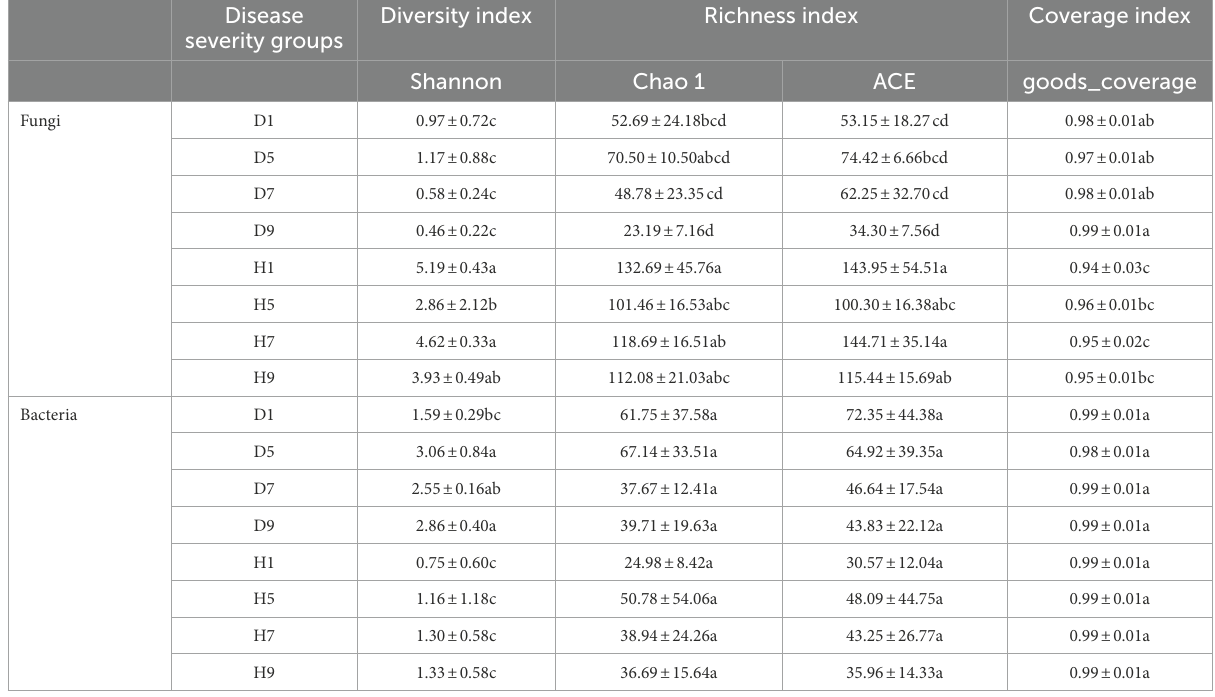
TABLE 2 Alpha-diversity indexes of fungal and bacterial community based on high-throughput sequencing in different